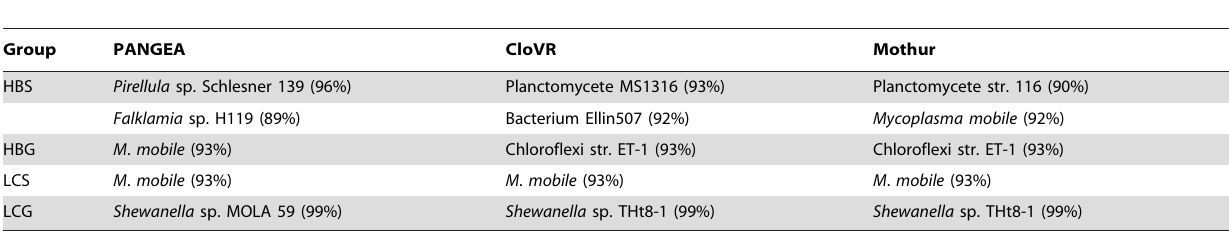
Table 3. Taxonomic affiliation of the most abundant OTUs (evolutionary distance =0.03) in Crassostrea virginica stomach (S)